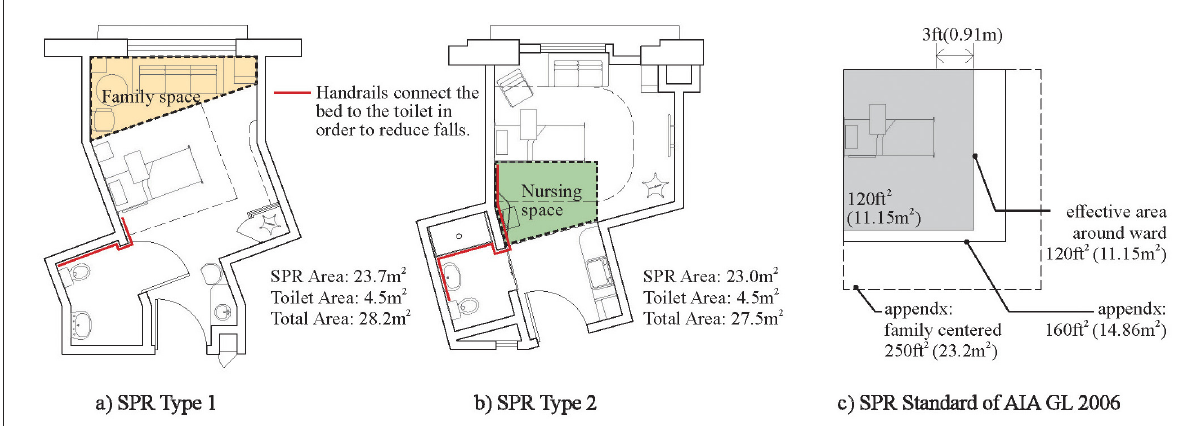
FIGURE5 Typical SPRs in the USA. (A) SPR Type 1. (B) SPR Type 2. (C) SPR Standard of AIA GL